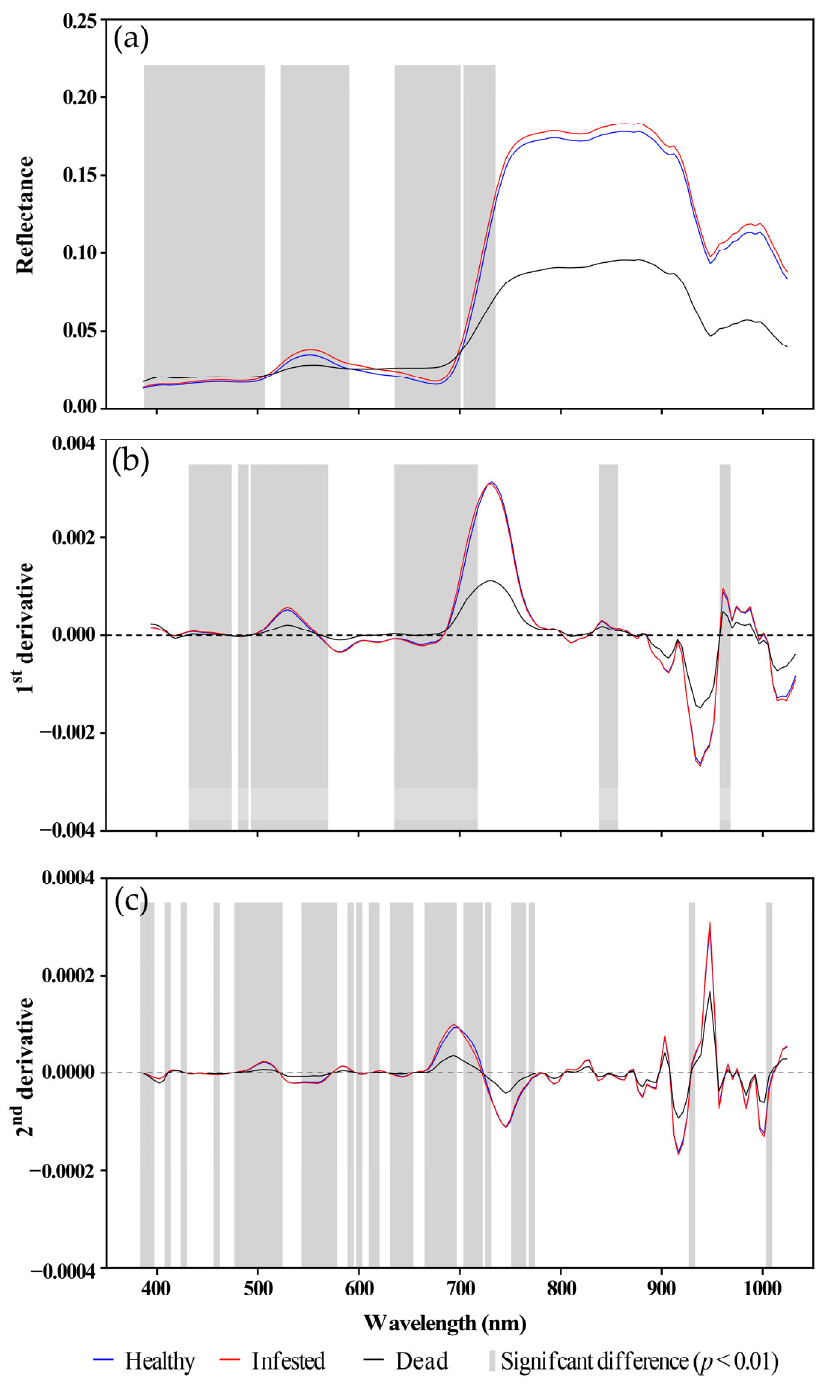
Figure 7. Mean crown spectra with 1st and 2nd derivatives. The blue, red and black lines indicate healthy, infested and dead trees, respectively, and grey areas indicate significant differences between any two groups. ( a ) Average spectral reflectance; ( b ) average first derivatives; ( c ) average second